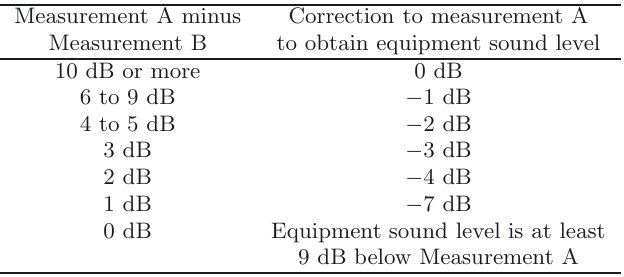
Table 2. Guidelines for determining equipment sound levels in presence of contaminating background